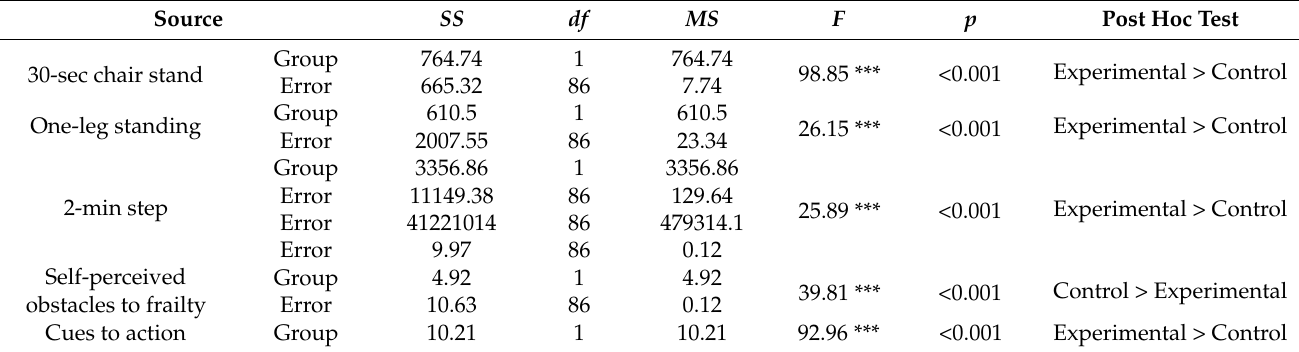
Table 4. Summary of post-test ANCOVA of the two groups for biomarkers and health